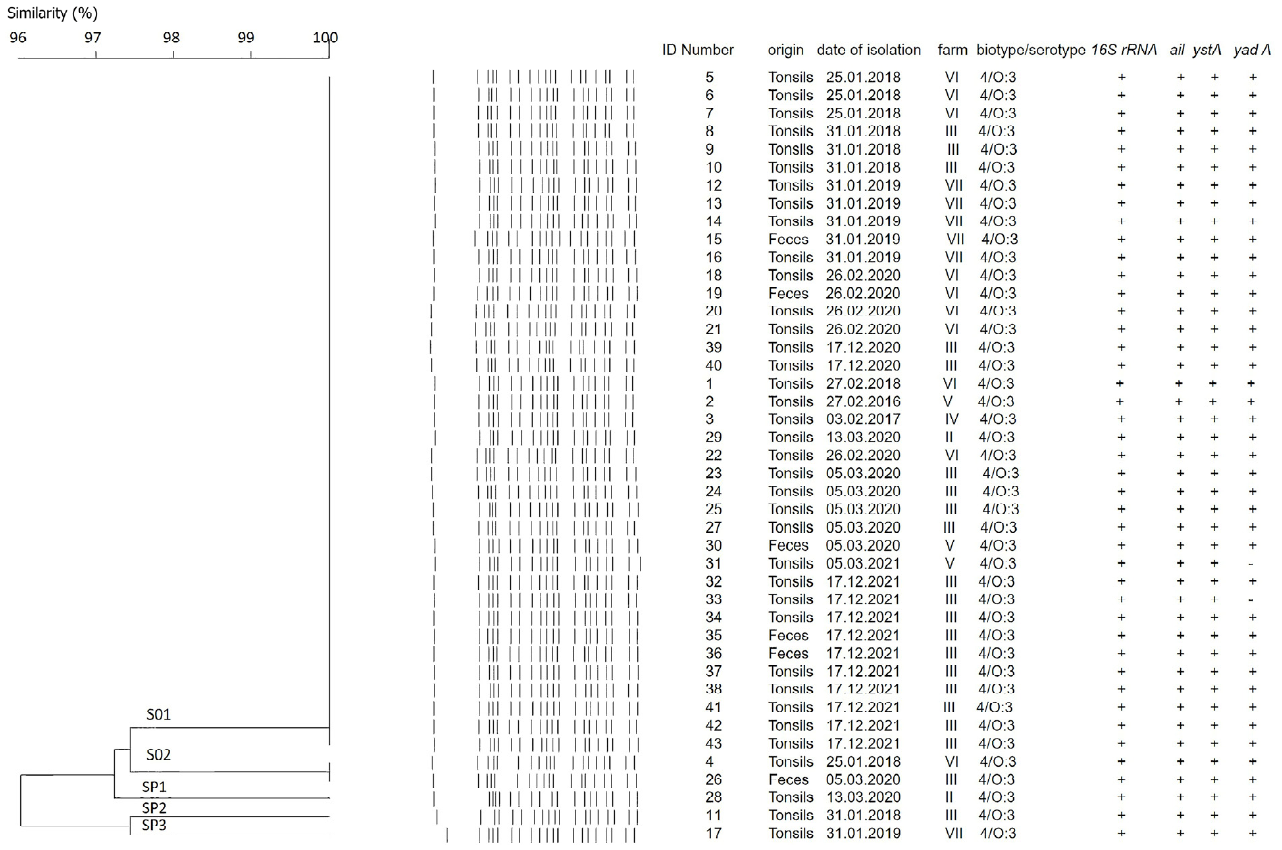
Figure 3. Dendrogram obtained derived by digesting Y. enterocolitica genomic DNA with Spe I. The DNA of 43 examined strains formed two different clusters, assigned S01 and S02, and three single pulsotypes, named SP1, SP2, and SP3. Clustering was calculated by the Unweighted pair group method with arithmetic mean (UPGMA) with 97% similarity. Dice correlation was with tolerance of 2.5% and optimization setting of 0.5. Additional information about dates of isolation, farm distribution, and virulence profile of the strains is given.